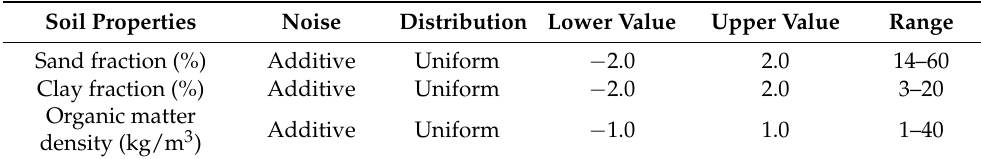
Table 3. Perturbations in the soil property data used in this